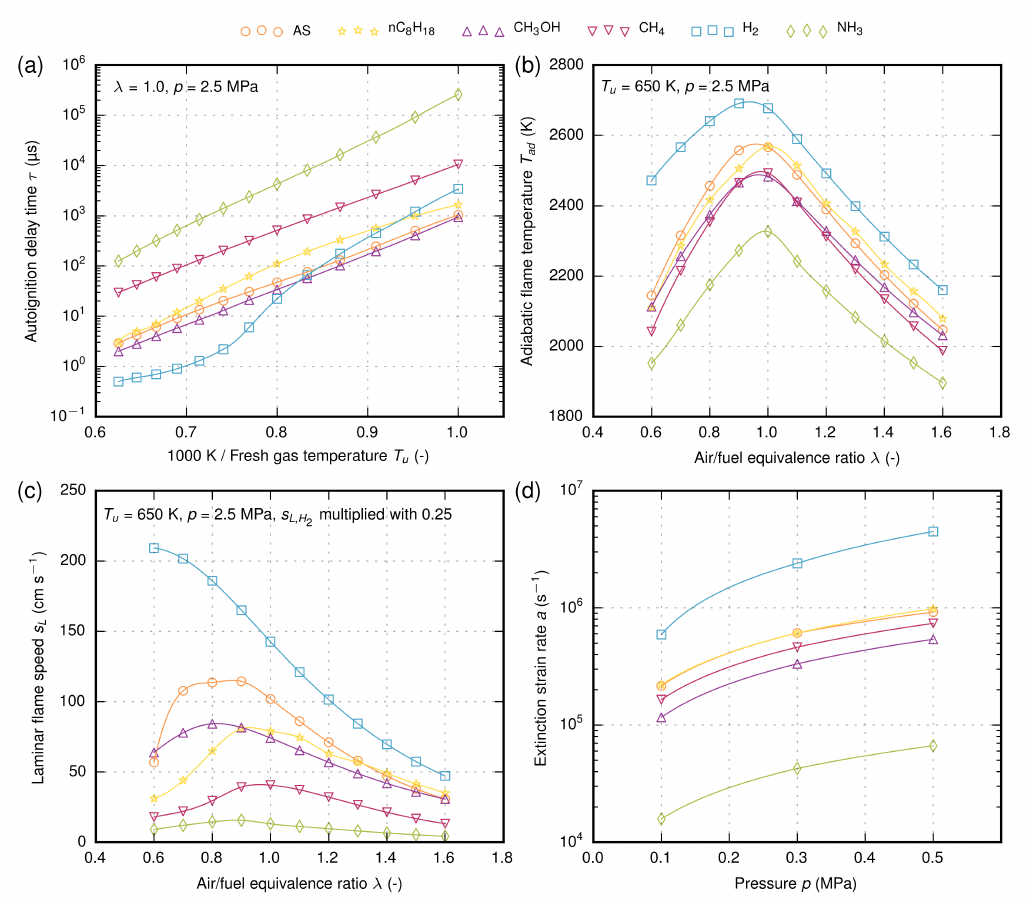
Figure 5. Combustion properties of different electrofuels (symbols are calculated values; lines are interpolated values): ( a ) Autoignition delay time; ( b ) Adiabatic flame temperature; ( c ) Laminar flame speed; ( d ) Extinction strain